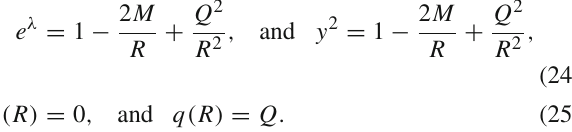
Fig. 1 The energy density, pressure, charge and density-pressure in their normalized forms as a function of the radial coordinate are shown on the panels from top to bottom for the compact star candidates SAX J1808.4-3658, 4U 1538-52 and Her X-1. For plotting, we choose the values of physical parameters and constants are as follows: (i)